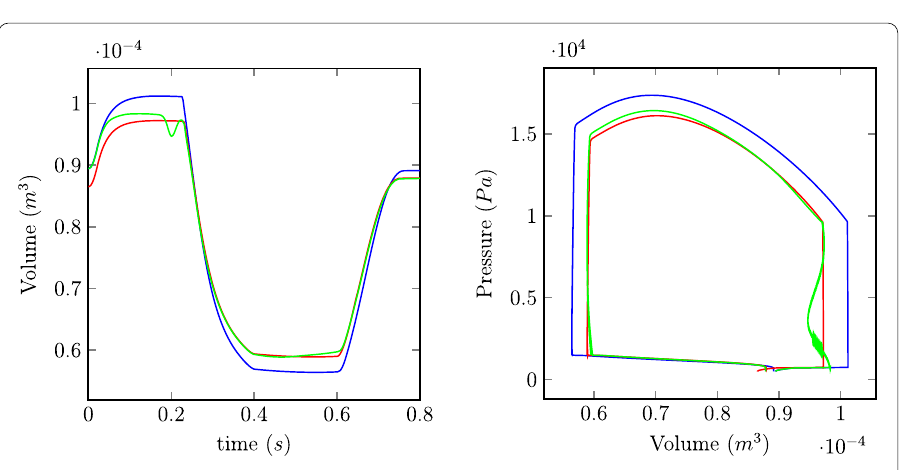
Fig. 15 Estimation of active (top) and passive (bottom) parameters using apparent displacements